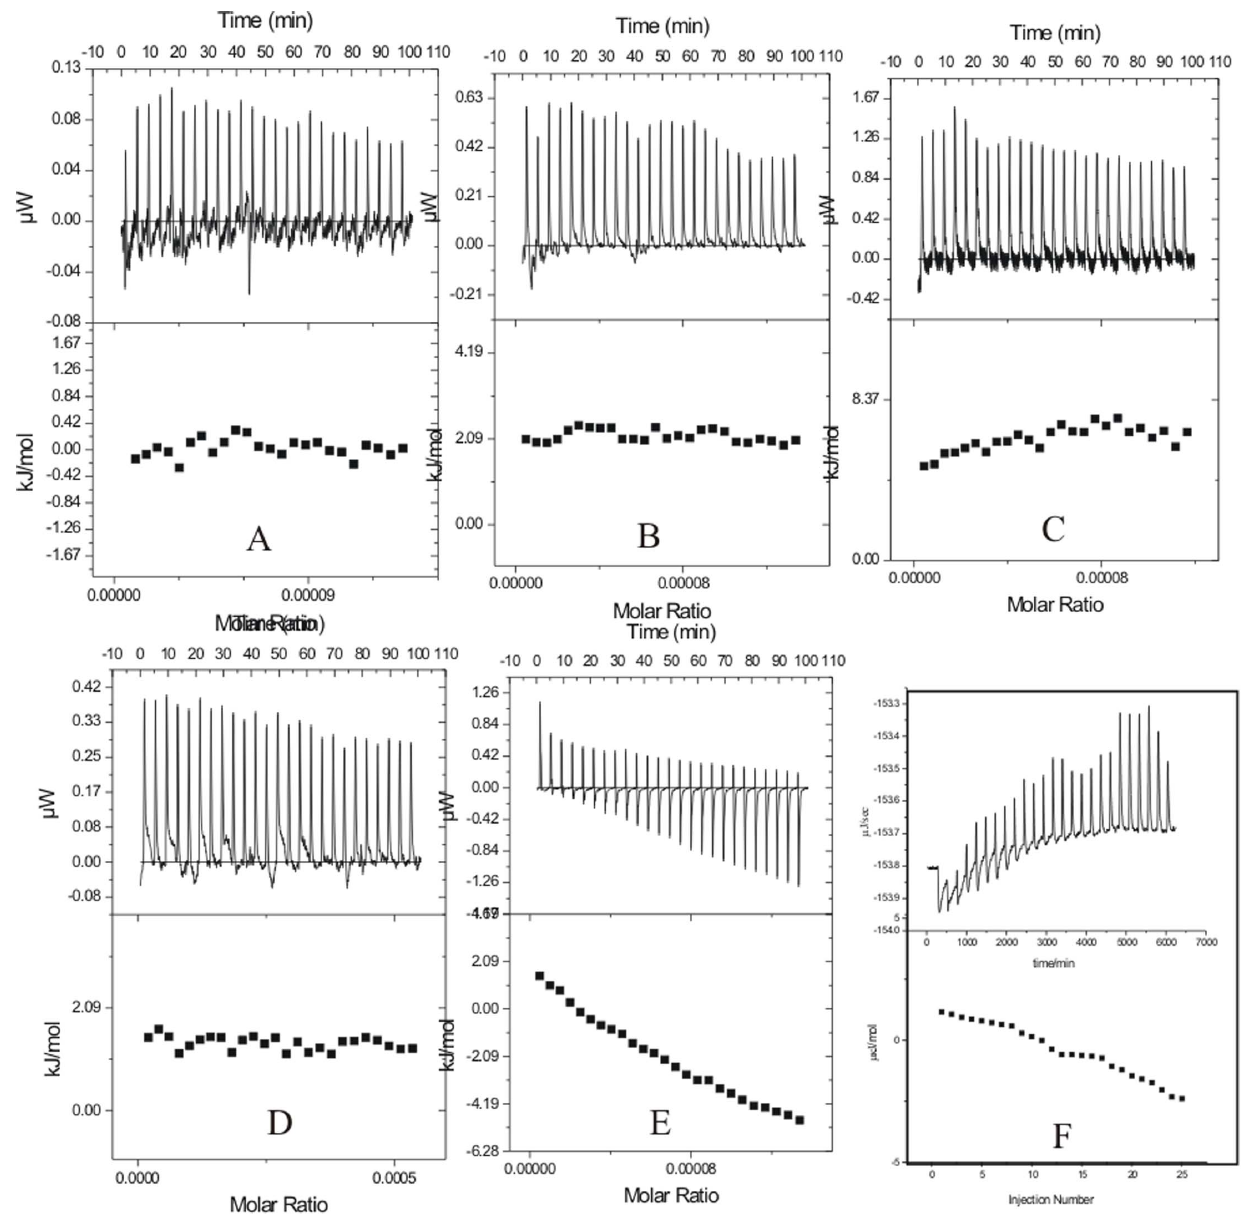
Figure 3. Representative ITC profiles for the titration of (A) lysozyme with buffer at 25 6 C, and (B) lysozyme at 37 6 C (C) lysozyme at 60 6 C, and heat induced aggregates of lysozyme after incubation period of (D) 48 h, (E) 61 h, and (F) 90 h.